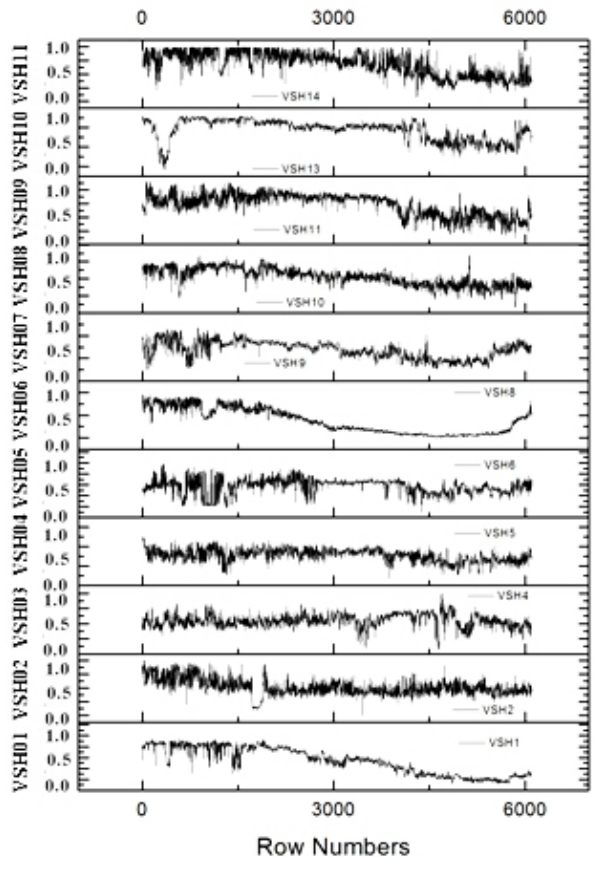
Fig. 1. Shale volume traces used in the